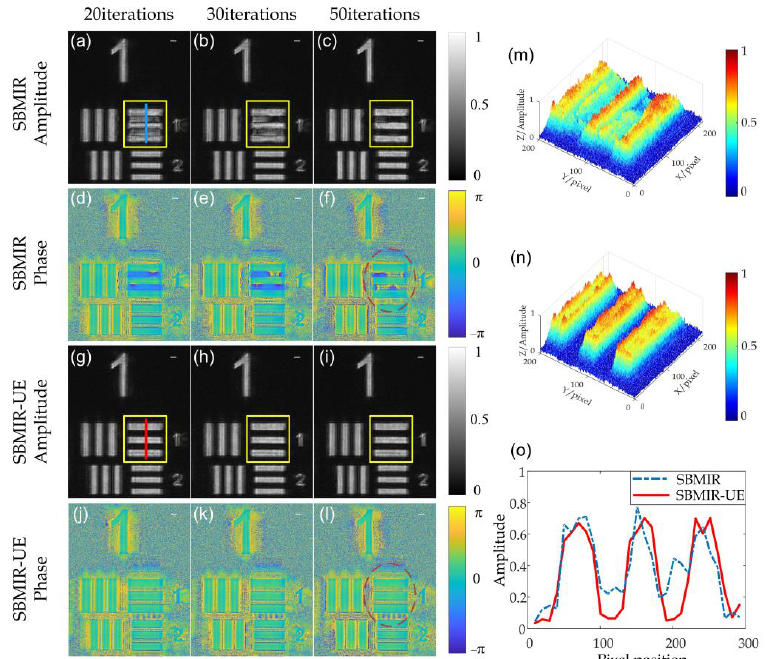
Figure 6. The reconstruction results of the amplitude-type resolution plate: ( a - c ) and ( g - i ) are the reconstructed amplitudes using SBMIR and SBMIR-UE algorithm after 20, 30 and 50 iterations, respectively; ( d - f ) and ( j - l ) are the corresponding reconstructed phases; ( m - n ) the 3D images of yellow squares in ( a ) and ( g ); ( o ) the amplitude of blue and red lines marked in ( a ) and ( g ). The white bars in ( a - l ) indicate the length of 125 μm.